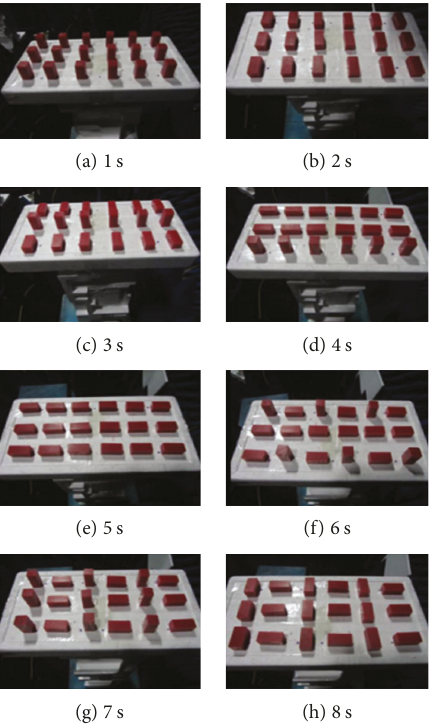
Figure 11: Overhead view of the MIMO antenna positions.